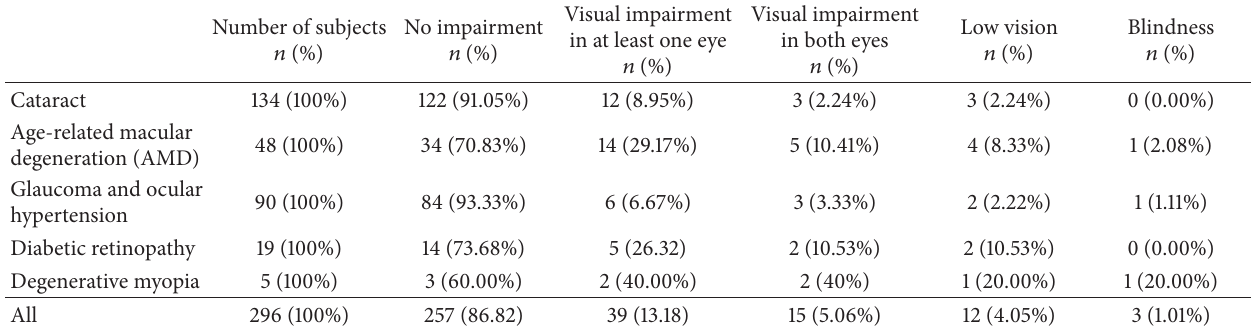
Table 3: Visual acuity distribution among subjects with age-related eye diseases ∗